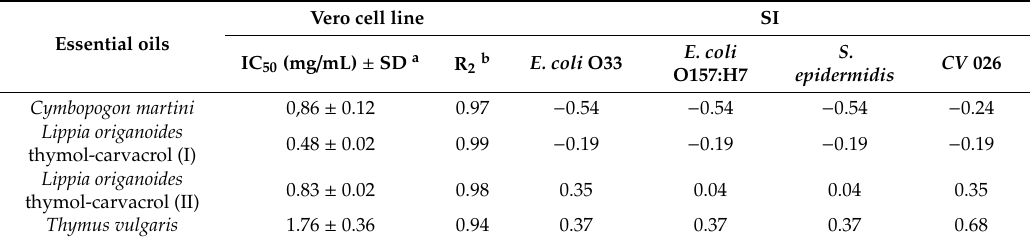
Table 3. Inhibitory concentration 50 (IC 50 ) and selectivity index (SI) values determined for the selected essential oils.